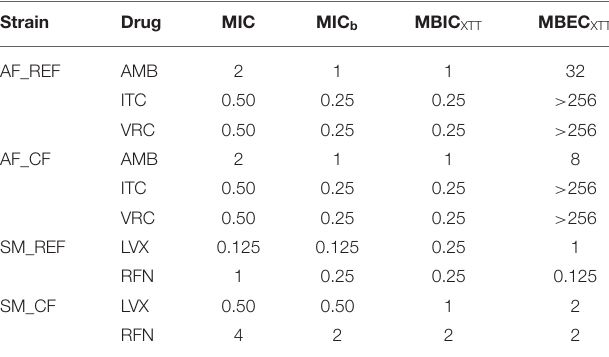
TABLE 1 | Efficacy of drugs to inhibit growth of planktonic cells and to reduce metabolic activity of biofilm cells.